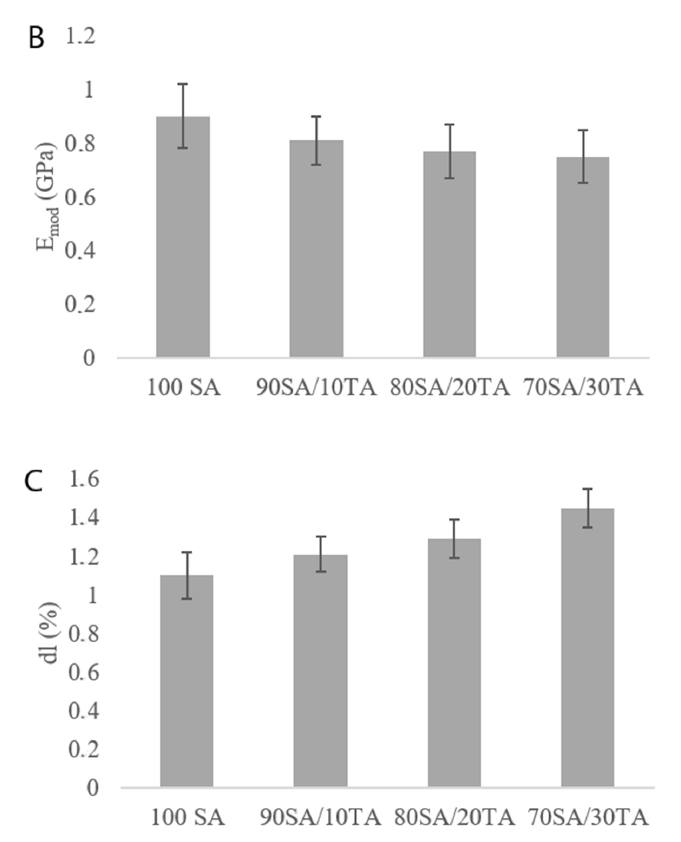
Figure 2. Mechanical parameters of sodium alginate / tannic acid films. ( A ) Maximum tensile strength, ( B ) Young’s modulus and ( C ) elongation at break.